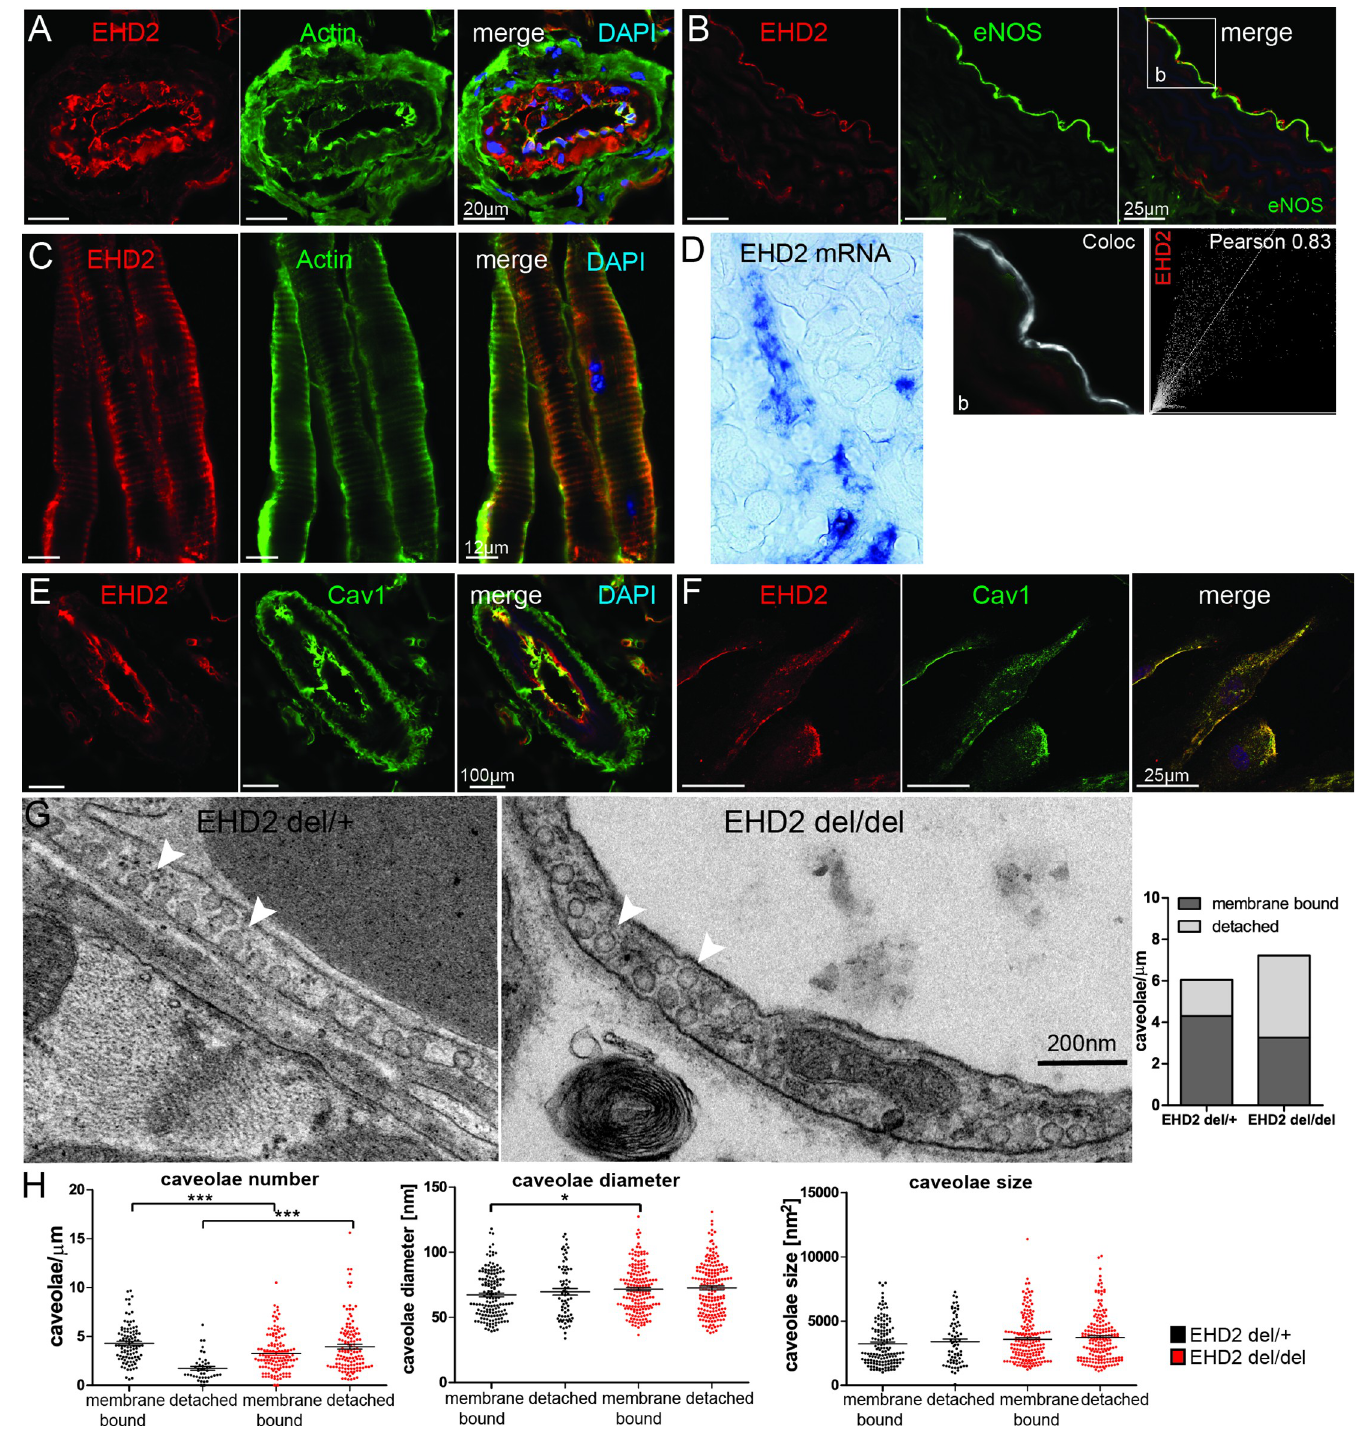
Fig 1. EHD2 is expressed in endothelial cells and stabilizes caveolae at the plasma membrane. (A) Cryostat section of adult C57BL/6N small arteries in brown adipose tissue stained against EHD2 and actin. (B) EHD2 and eNOS stained in aorta cryostat sections obtained from C57BL/6N mice illustrating co-localization of both proteins within the endothelium. (C) Cryostat sections of lymphatic vessels were stained against EHD2 and actin. (D) In situ hybridization of a C57BL/6N E18.5 embryo showed strong EHD2 expression in blood vessels. Cryostat sections of adult C57BL/6N mesenteric arteries (E) and HUVEC cells (F) stained against Cav1 and EHD2 revealed EHD2 localization at caveolae. (G) Representative EM images of EHD2 del/+ and EHD2 del/del arteries in which caveolae number, size and diameter were determined. (H) EHD2 del/del mice showed an increased number of detached caveolae compared to EHD2 del/+, in which mainly membrane-bound caveolae were